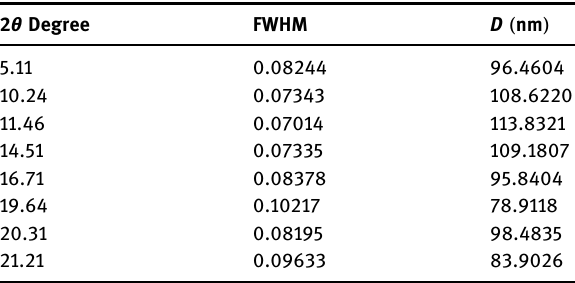
Table 2: Crystallites ( grain ) size D determination using